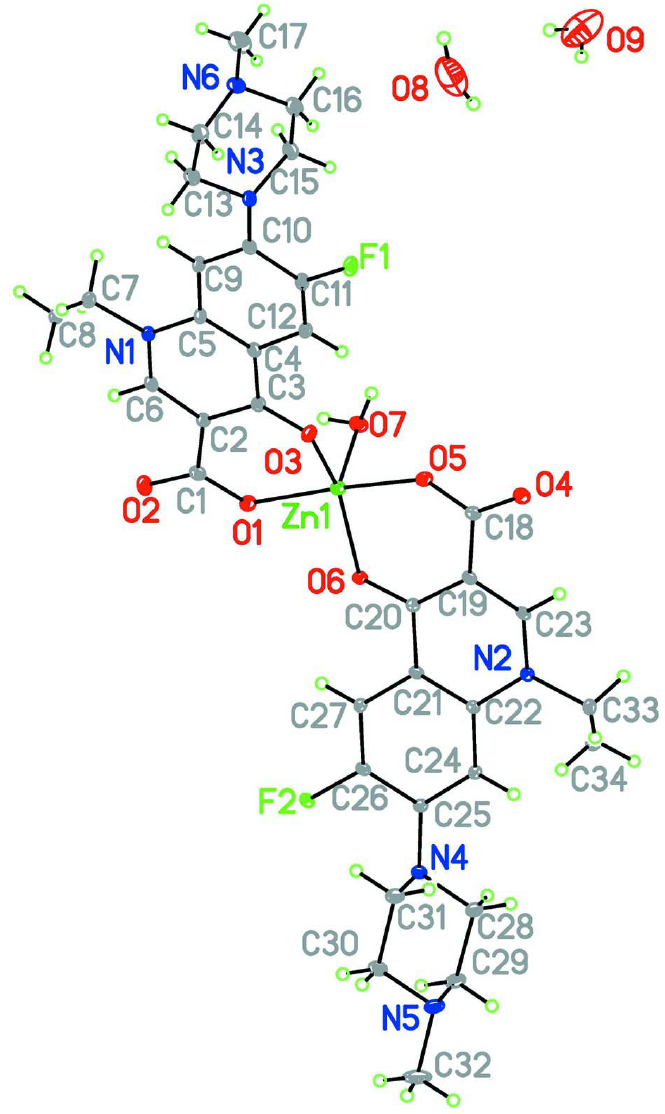
The asymmetric unit of the title compound showing the showing 50% displacement ellipsoids for non-H atoms. Aquabis[1-ethyl-6-fluoro-7-(4-methylpiperazin-1-yl)-4-oxo-